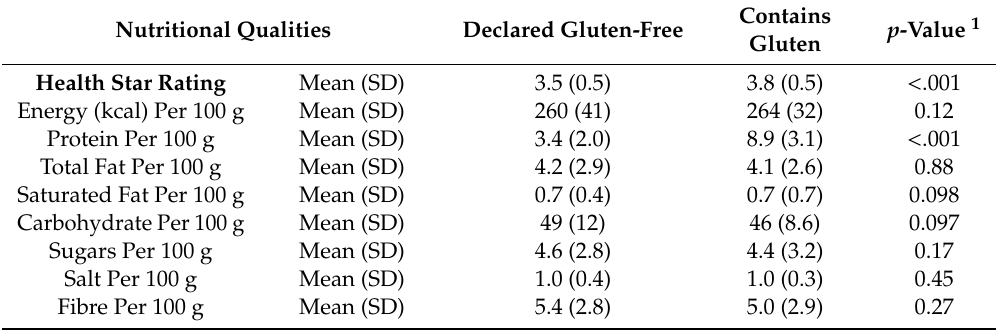
Table 2. Nutritional qualities of di ff erent bread products in Swedish supermarkets divided by their gluten content.